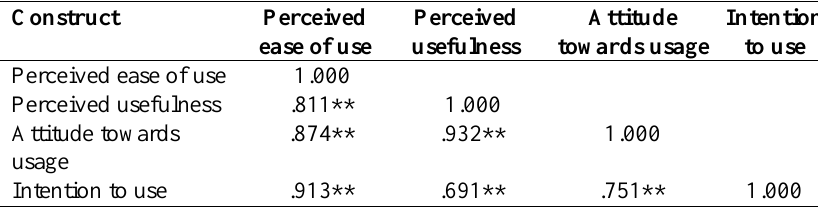
AVE square roots and